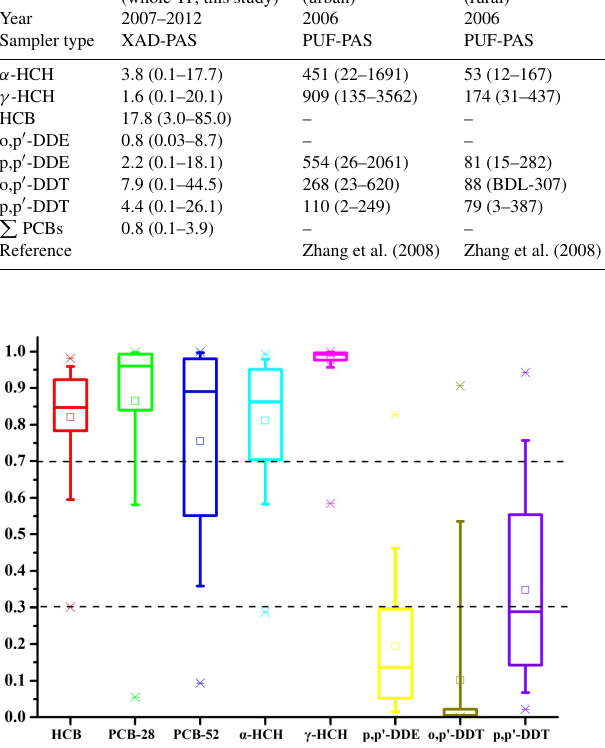
Table 3. Concentration results of this study and the comparison with literature values reported for the surrounding countries (pgm − 3 ). Sampling site TP